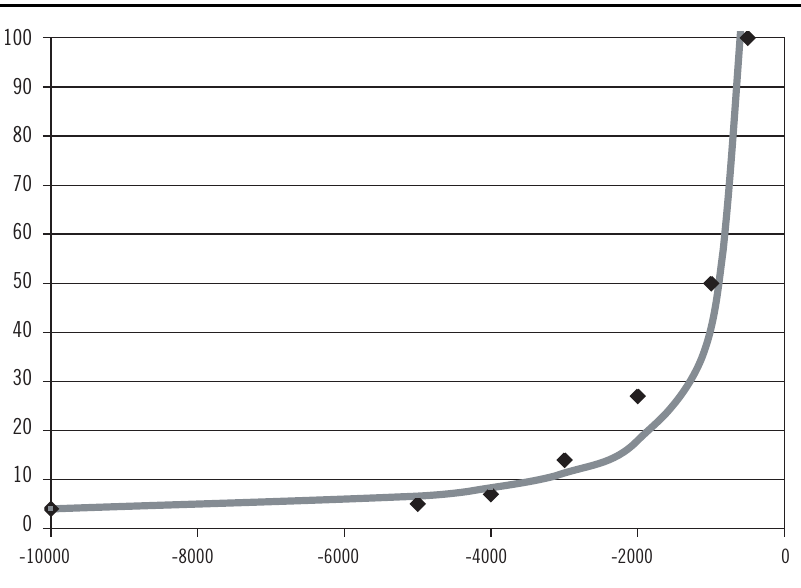
Figure 5 – Predicted and Observed Dynamics of World Population Growth,